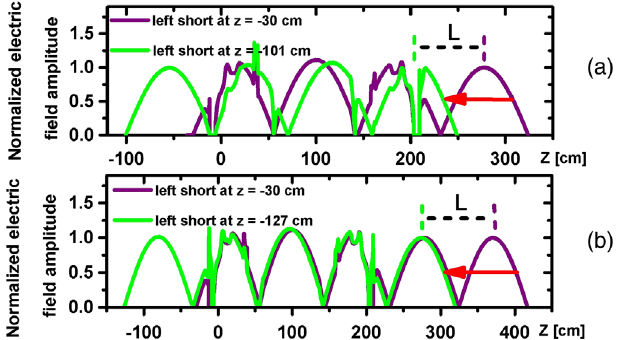
FIG. 5. The normalized electric field magnitude in the cavities with four and five aninodes. These magnitude results correspond to the field distributions shown in Fig. 4, and are evaluated along the longitudinal lines at the same transverse position in the cavities. (a) shows the normalized electric field magnitude in the cavities with four field antinodes; (b) depicts the normalized electric field magnitude in the cavities with five field antinodes.